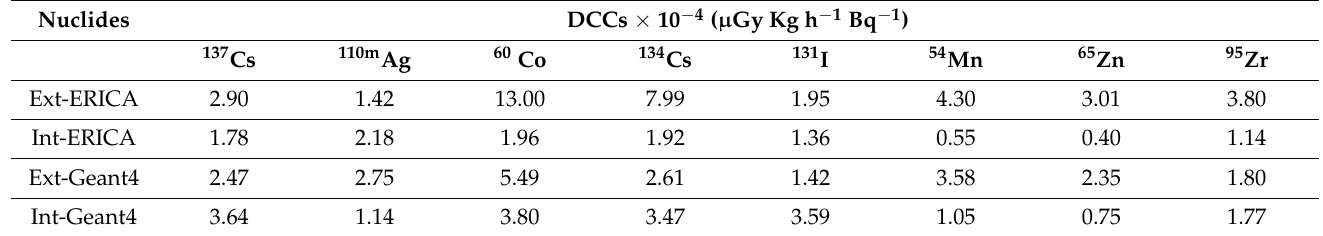
Table 7. Internal and external dose conversion coefficients of whole-body O. bartramii obtained with the ERICA tool and